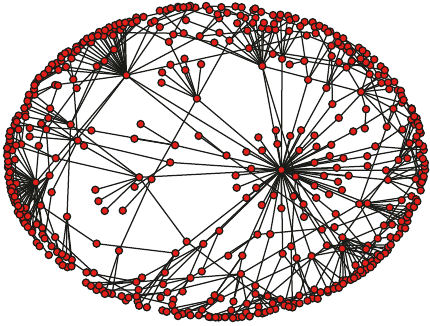
Figure 1: Scale-free network A.